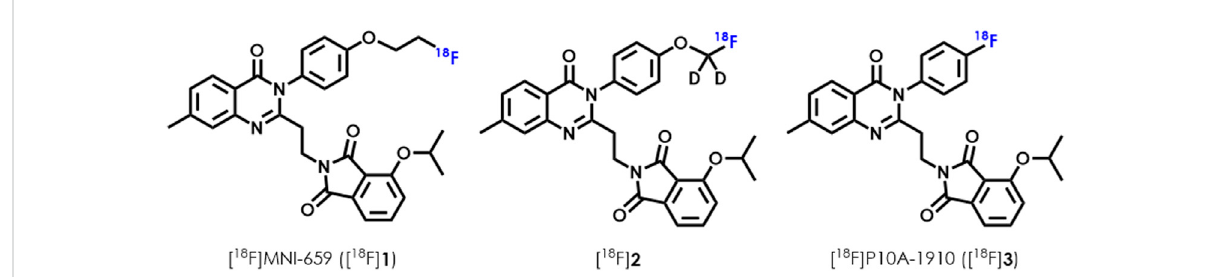
FIGURE 1 Representative PET ligands for imaging PDE10A: [ 18 F]MNI-659 and their